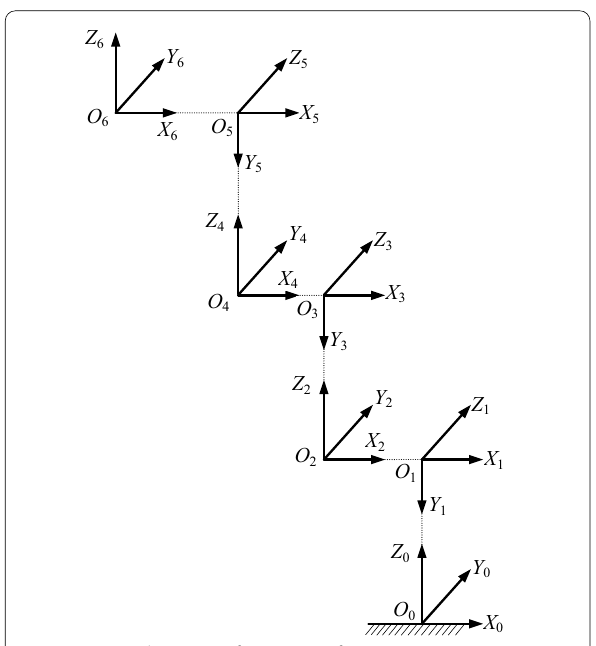
Figure 2 Coordinate transformations of a six-axis